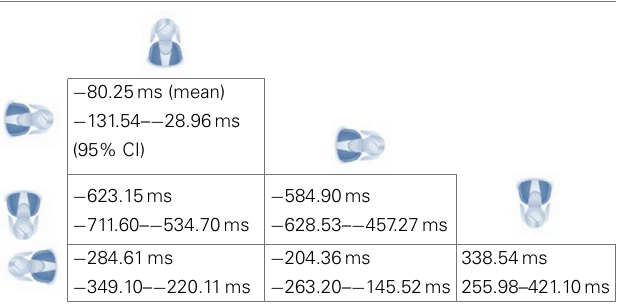
Table 2 | Mean differences and 95% confidence intervals for the four image